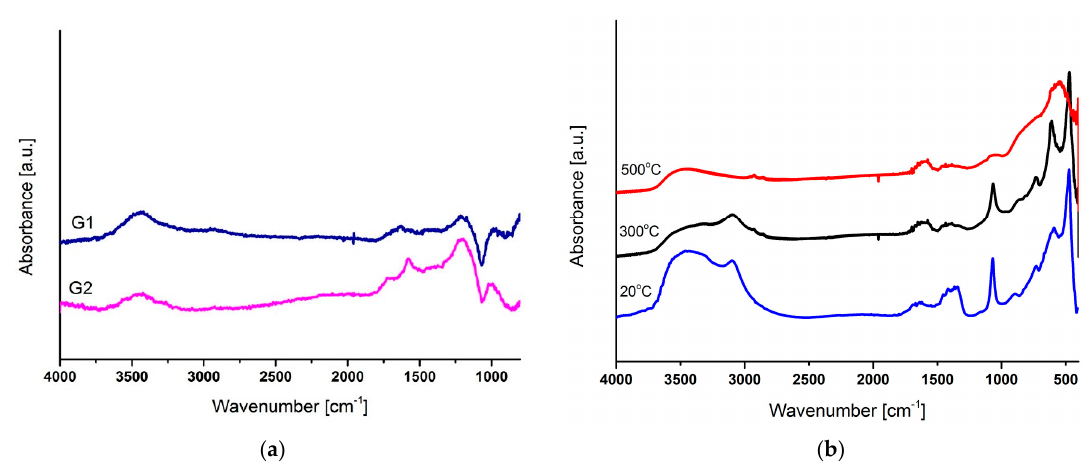
Figure 4. Fourier-transform infrared (FTIR) spectra of ( a ) G1 and G2 graphene powders and ( b ) Al 2 O 3 coatings heat treated at different temperatures.